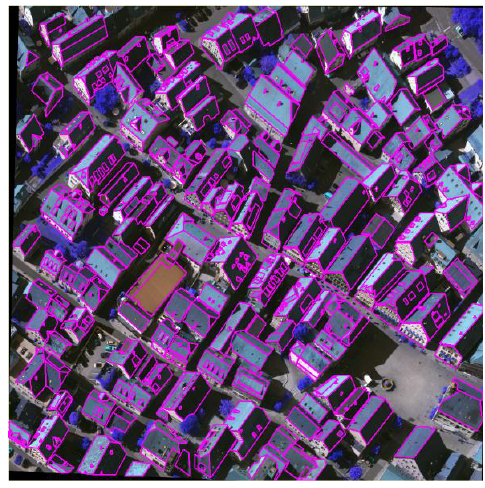
Fig.2 An example of the segmentation results.